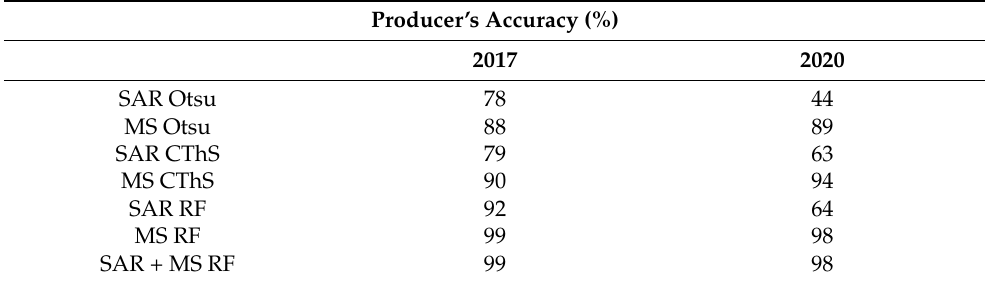
Table 5. Water classification accuracies for the case studies of Enza (the event in 2017) and Sesia rivers (the event in